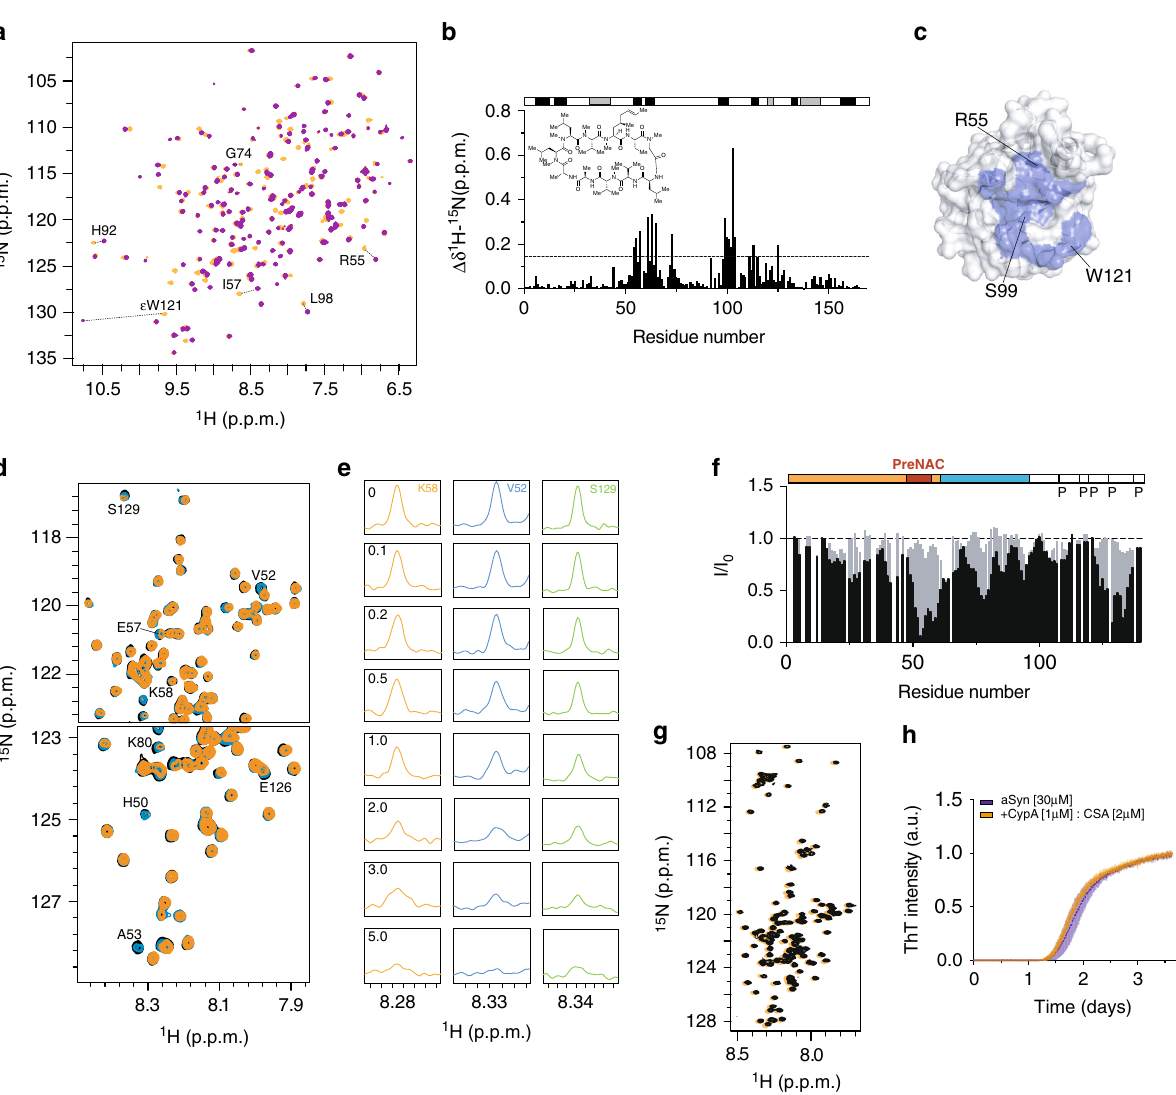
Fig. 3 Cyclosporin A inhibits aSyn-directed CypA activity. a Superposition of 1 H – 15 N HSQC spectra of CypA in the absence (orange) and presence (purple) of cyclosporin A. Selected cross-peaks are labeled by residue type and number. b Residue-speci fi c chemical shift perturbation observed in ( a ). The chemical structure of cyclosporin A is shown as the inset. The location of α -helices (gray) and β -strands (black) is illustrated on top. c Mapping of cyclosporin A-induced chemical shift changes onto the 3D structure of CypA (PDB code: 6I42) . d Superposition of selected regions of 1 H – 15 N HSQC spectra of 15 N-labeled aSyn in the presence of increasing concentrations of CypA (CypA:aSyn molar ratios of 0:1, 1:1, and 5:1 in black, blue, and orange, respectively). e One-dimensional 1 H traces through the 1 H – 15 N cross-peaks of V52, K58, and S129 of aSyn shown in ( d ). CypA:aSyn molar ratios are indicated in the panels of K58. f Residue-speci fi c attenuation of cross-peaks in 1 H – 15 N HSQC spectra of aSyn upon addition of a fi vefold molar excess of CypA (black) and CypA:CSA complex (gray). I 0 and I are the intensities of 1 H – 15 N HSQC cross-peaks in the absence and presence of the enzyme/complex, respectively. The domain organization of aSyn and the location of proline residues is shown on top. g Superposition of 1 H – 15 N HSQC spectra of aSyn in the absence (black) and presence (orange) of the CypA/CSA complex. h ThT- fi brillization assay of aSyn alone (30 μ M, blue) and in the presence of the CypA/ CSA complex (orange). The concentrations of CypA and CSA were 1 and 2 µ M, respectively. Data points represent the mean values from n = 4 independent experiments ±1